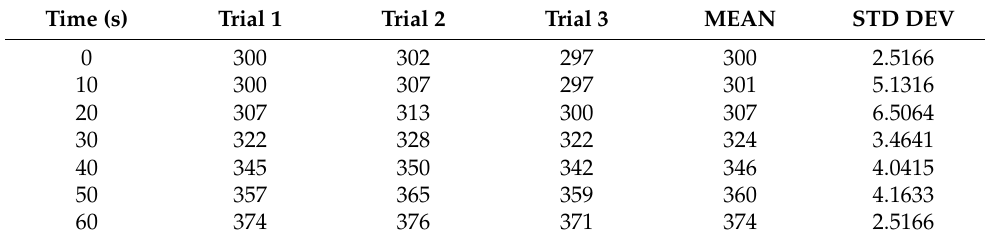
Table A1. Experimental data of oven air temperature (K) in Figure 2.